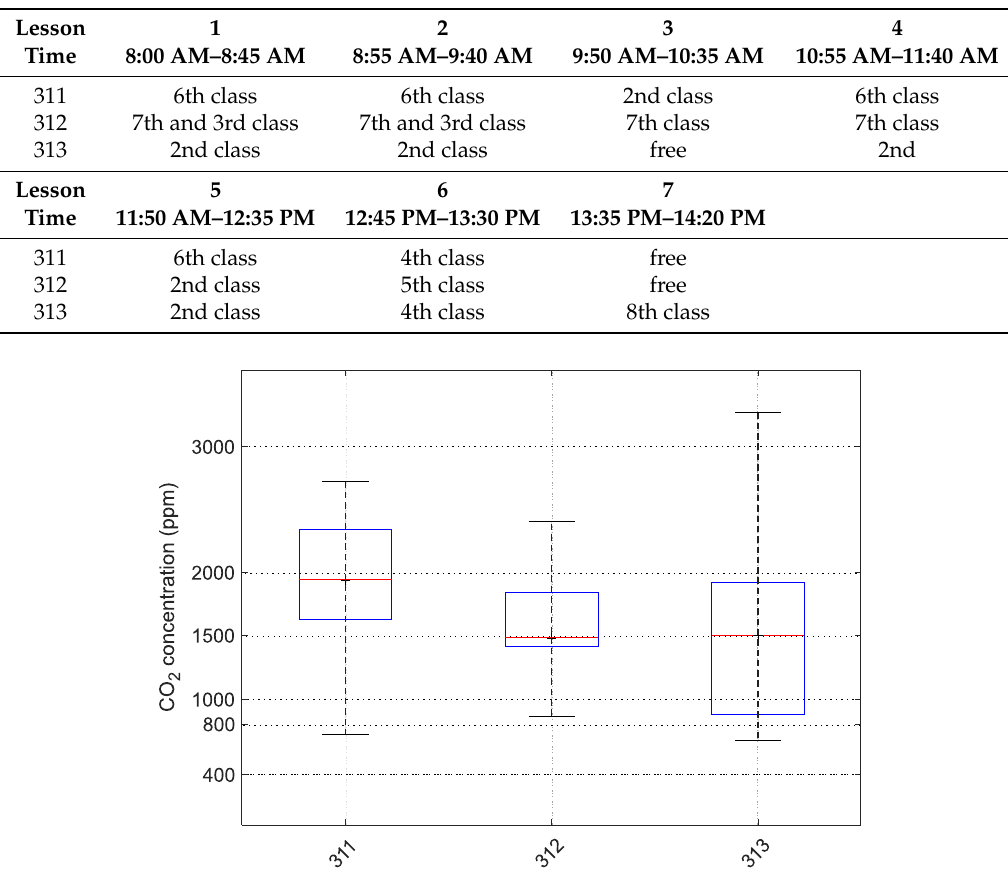
Table 2. Timetable for 15 January 2019 at the Grammar School and Secondary School of Electrical Engineering and Computer Science, Frenštát pod Radhoštˇem.